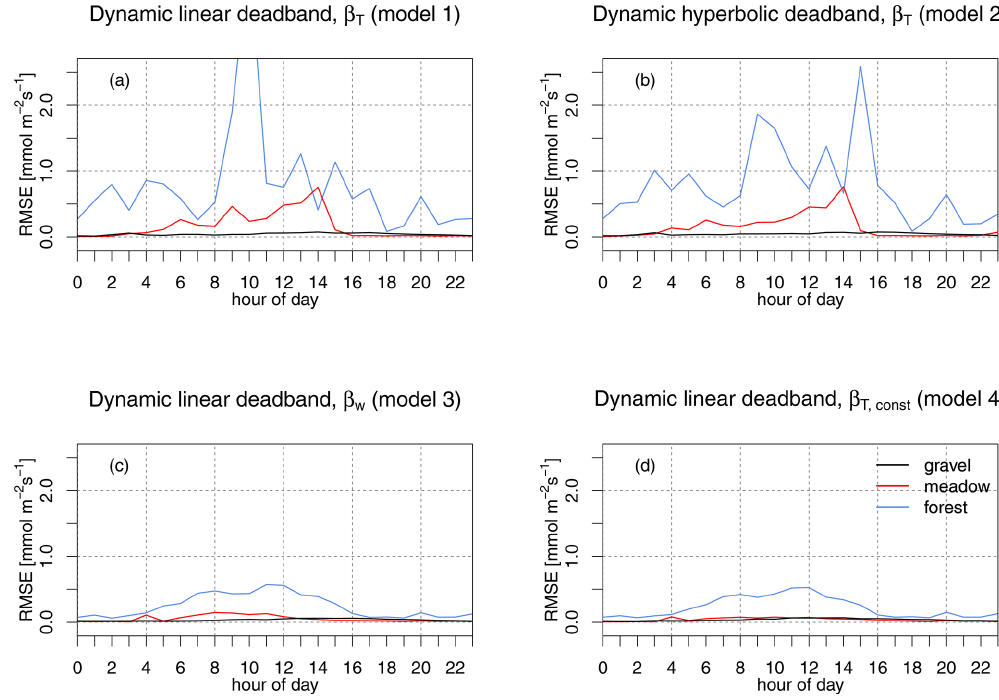
Figure 9. Flux RMSE as a function of the hour of day (local time) for each of the optimized β models. Panel (a) shows the RMSE of the proxy-based model using a dynamically adjusted linear deadband (model 1), scaled with 0.5 σ w . In this panel, there is one extreme value with RMSE > 3, which is outside of the plot boundaries. Panel (b) shows the proxy-based model using a dynamically adjusted hyperbolic deadband (model 2) with H = 0 . 5. Panels (c) and (d) show the RMSE of the β w REA model (model 3) and the constant β T, const approach (model 4), respectively, both with a dynamically adjusted linear deadband of width 0.5 σ w .